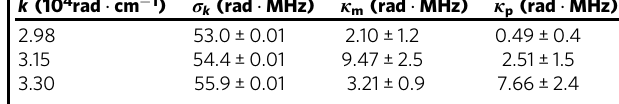
Errors presents standard